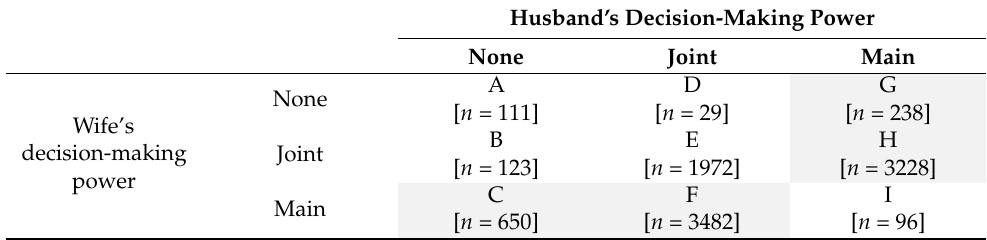
Table 1. Treatment and comparison group—decision-making